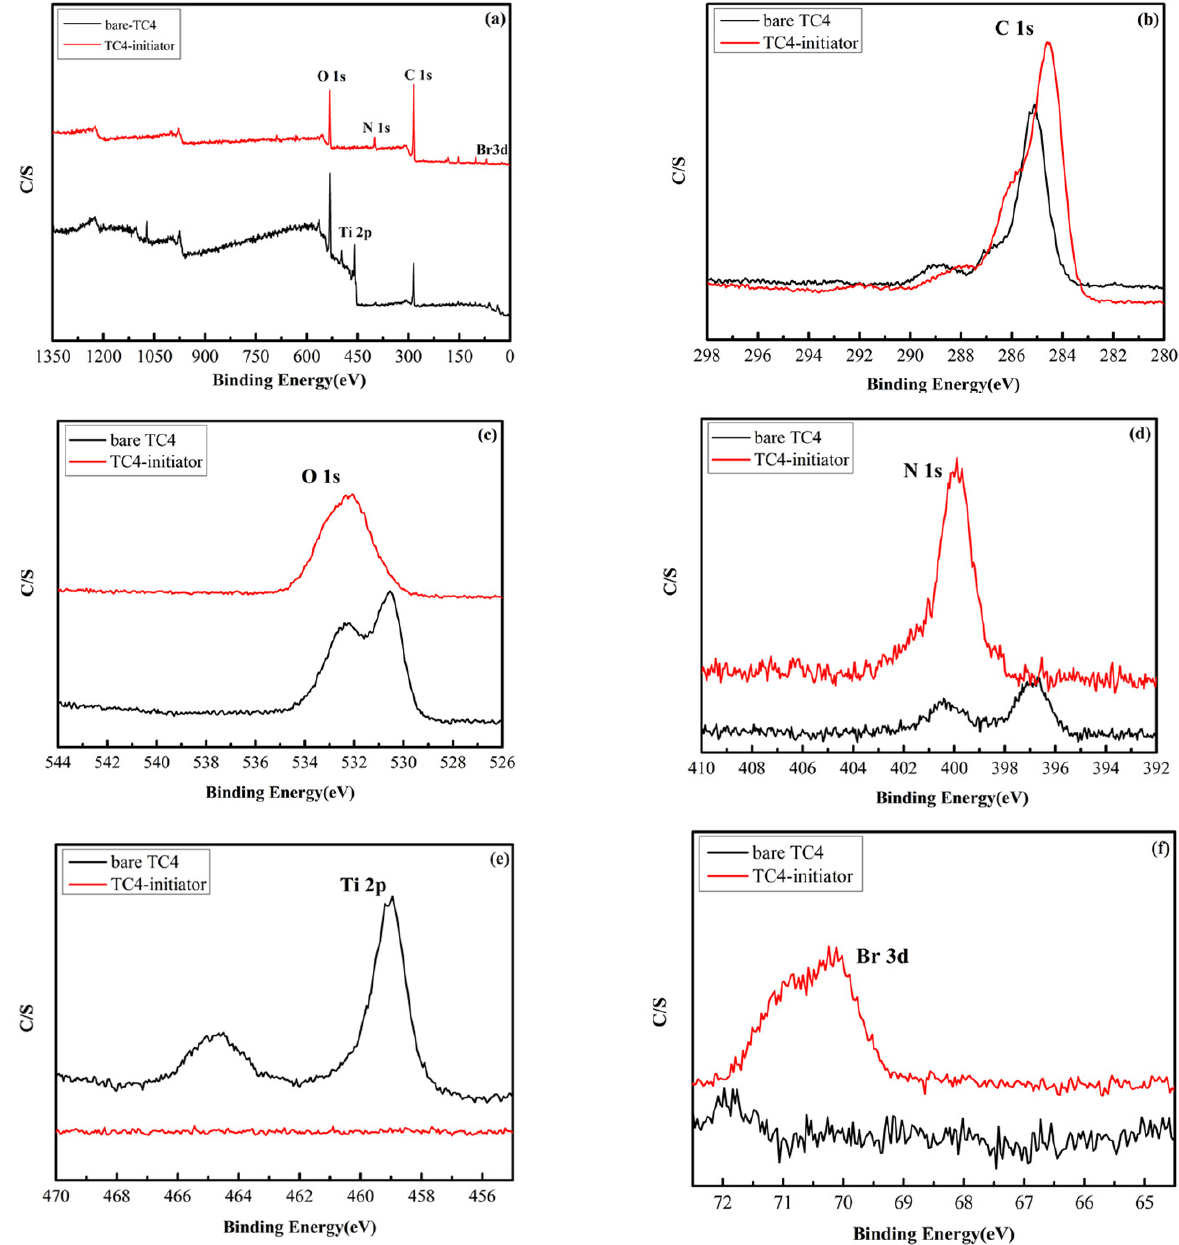
Figure 2. ( a )XPS spectrum of bare TC4 and TC4-initiator; high resolution scans of C 1 s ( b ), O 1 s ( c ), N 1 s ( d ), Ti 2 p ( e ) and Br 3 d ( f ) of bare TC4 and TC4-initiator.